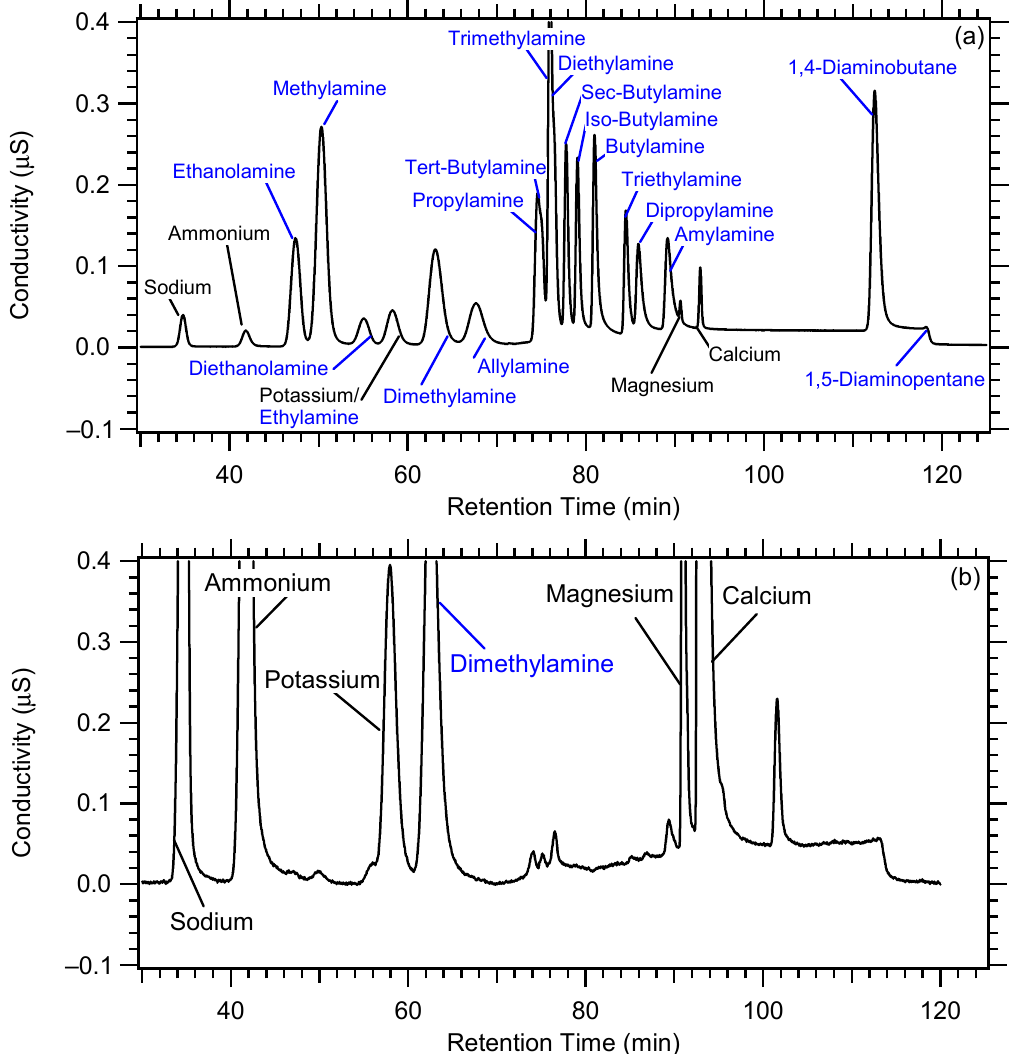
Figure 3. Chromatogram of ( a ) an amine calibration standard and ( b ) the same ambient filter sample collected in Sacramento County, CA shown in Figure 1. The separation was performed on a Thermo Scientific IonPac CS-19 (4 × 250 mm) column using the separation method described in the main text. Note the x -axis starts at 30 min since only lithium elutes before this retention time at 25 min. The peak observed at 102 min in plot b is unknown as currently no standard has been found to confirm its identity.